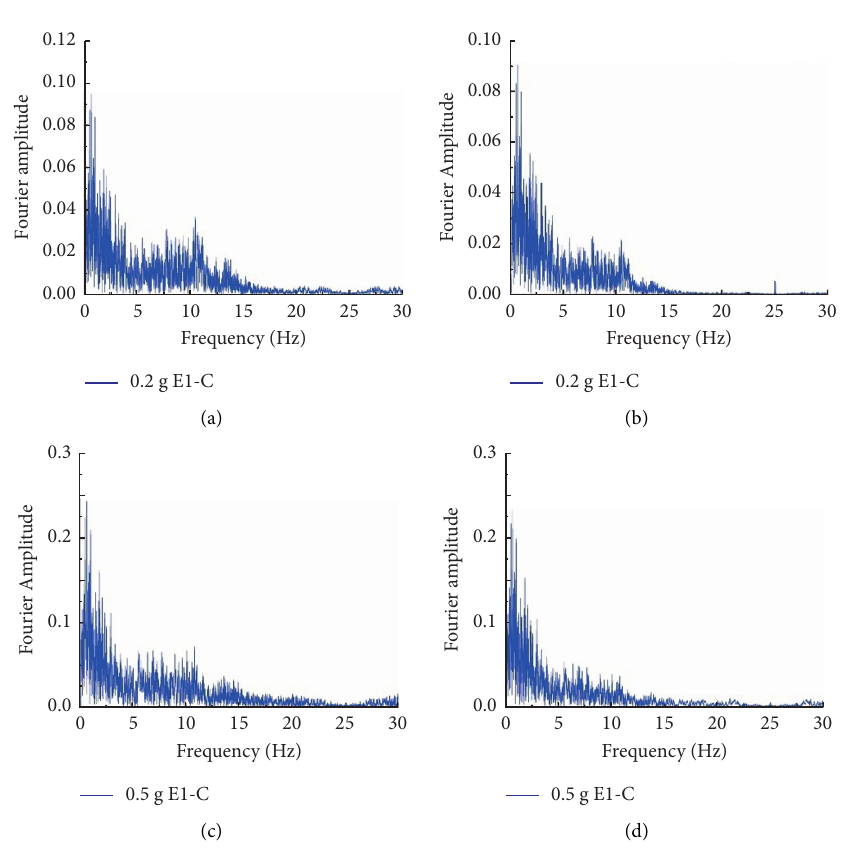
Figure 11: Fourier spectrum of the monitoring